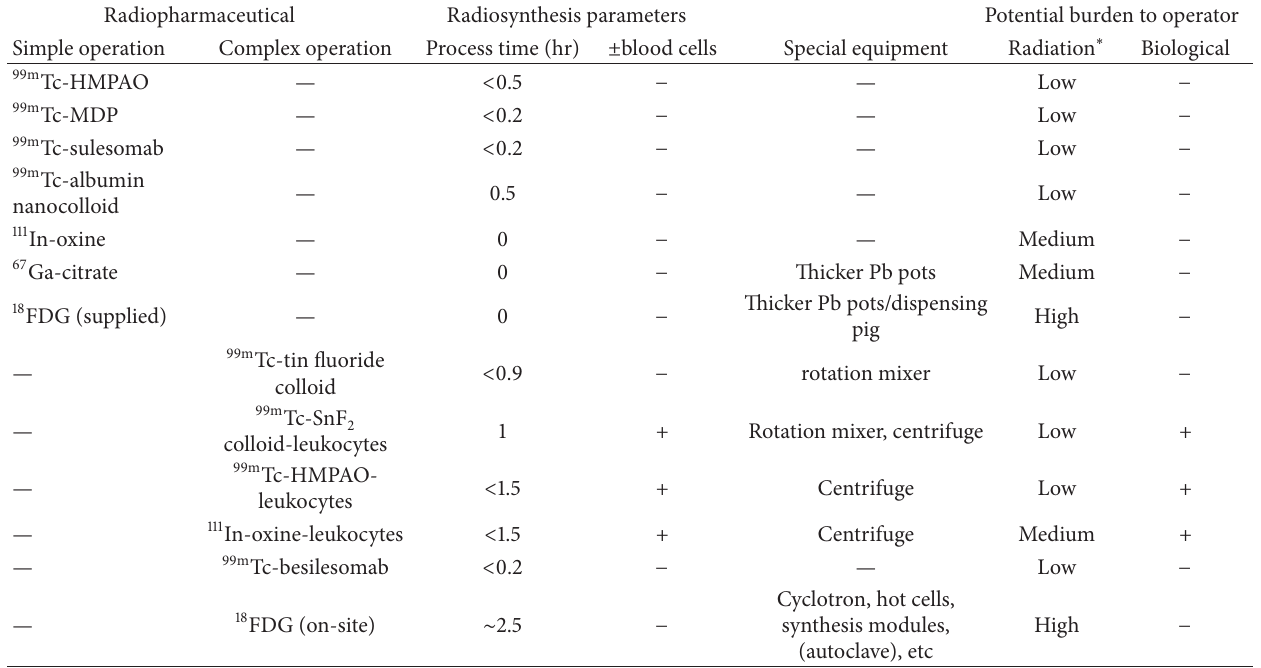
Table 3: Key parameters of radiolabeling